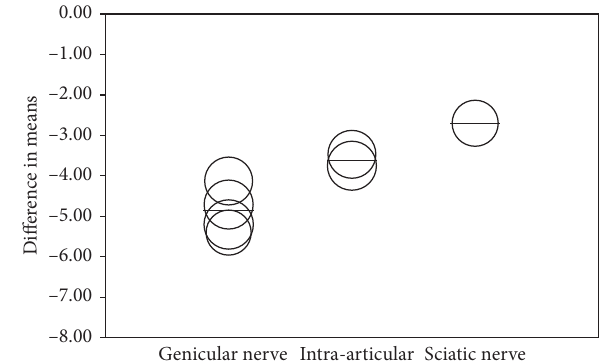
Figure 6: The correlation between treatment target and the pain scores in patients with knee osteoarthritis (KOA) by